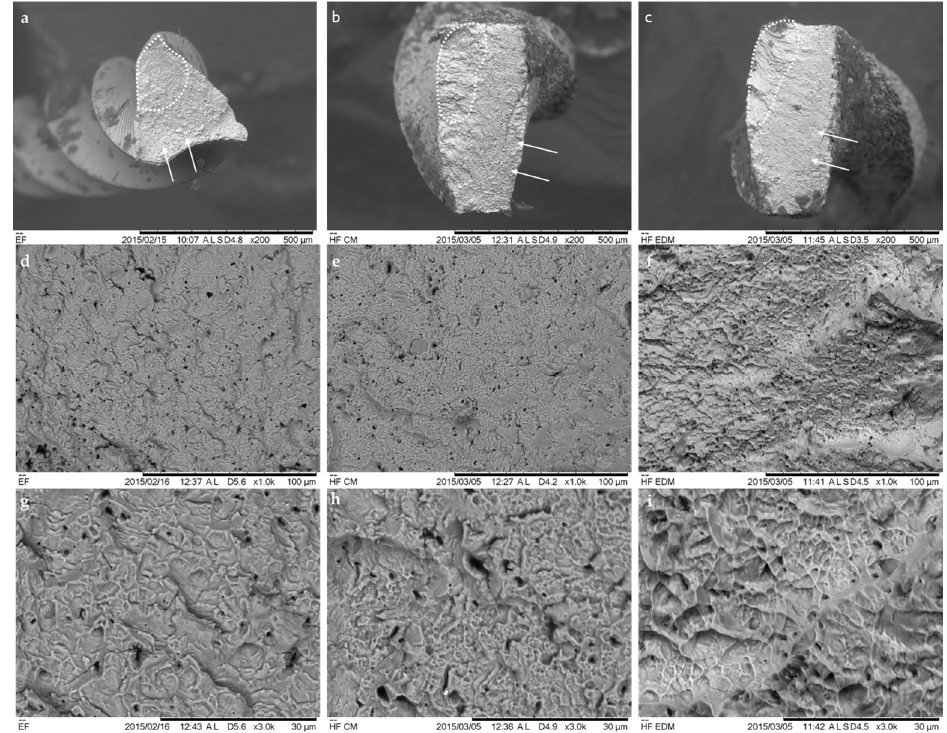
Figure 6. Representative SEM micrographs of the cross-sectional surfaces of fractured files at the ×500 (upper row), ×1000 (middle row) and ×3000 (lower row) magnifications. The typical fatigue propagation zone (dotted line) and dimpled area (white rows) were observed on EF ( a ), CM ( b ) and EDM ( c ) instruments. On higher magnifications, the detailed features of the dimpled area of EF ( d , g ), CM ( e , h ) and EDM ( f , i ) thermally treated files are evident.